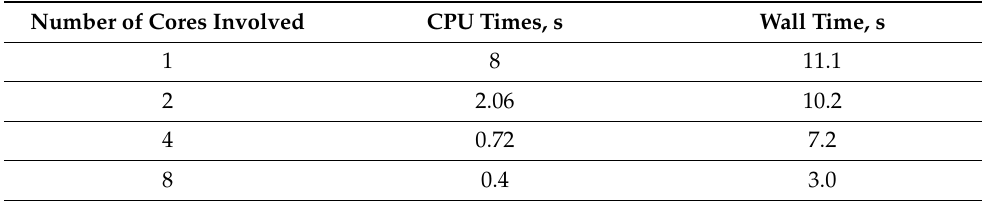
Table 10. The result of parallelizing the learning process across CPU cores for the k-nearest neigh- bors model.